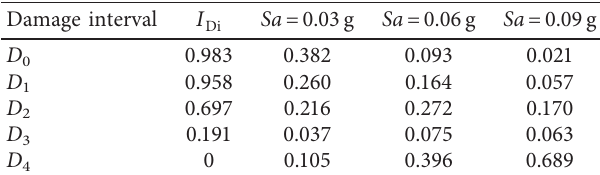
Figure 9: Different interval fragility curves. (a) Section R-A. (b) Section R-C. (c) Section R-F. Table 5: Seismic resilience of the stage index and damage prob- ability (section